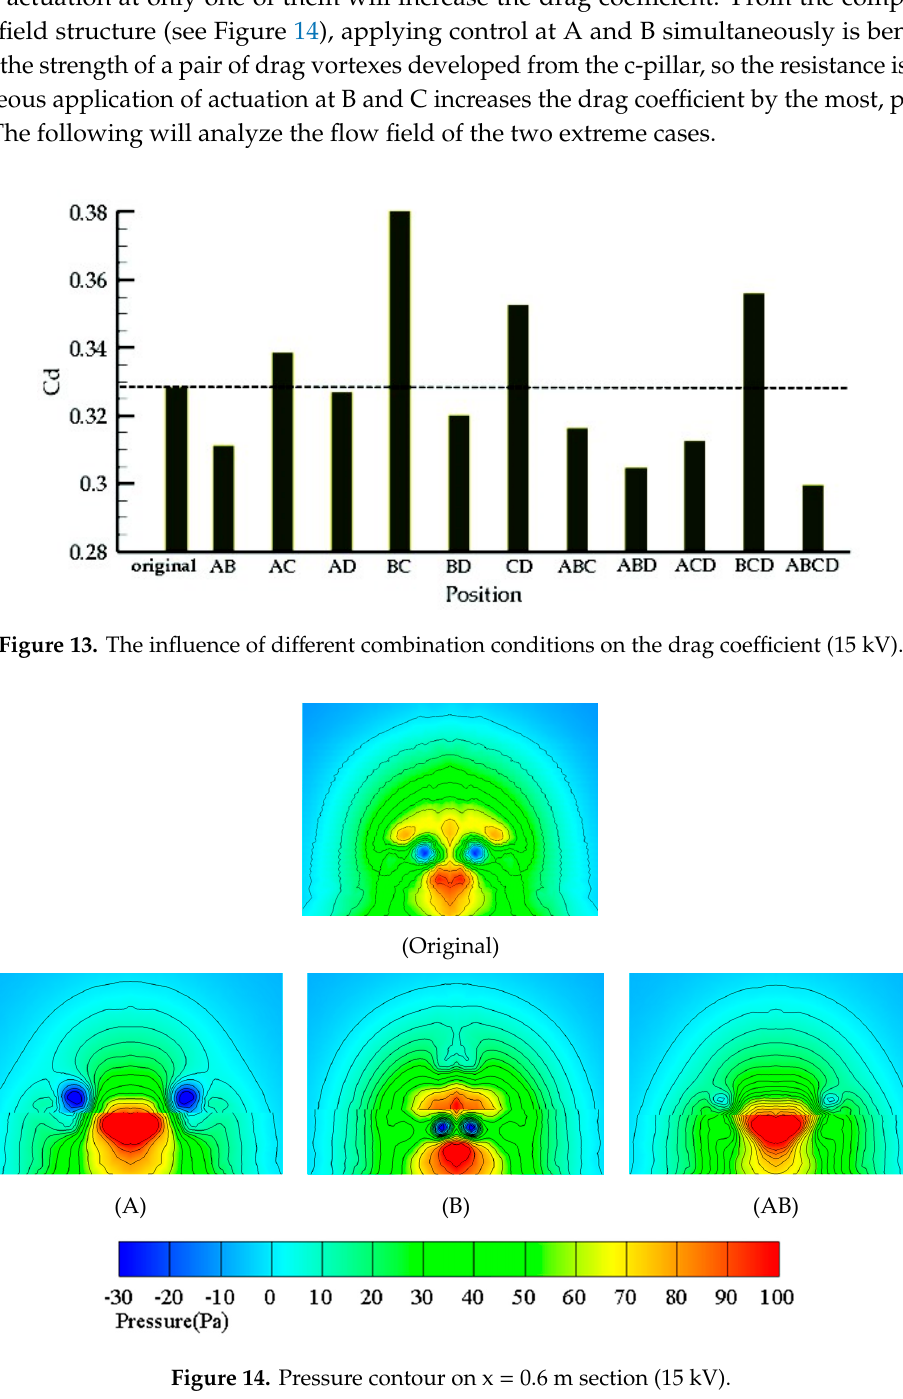
Figure 14. Pressure contour on x = 0.6 m section (15 kV).